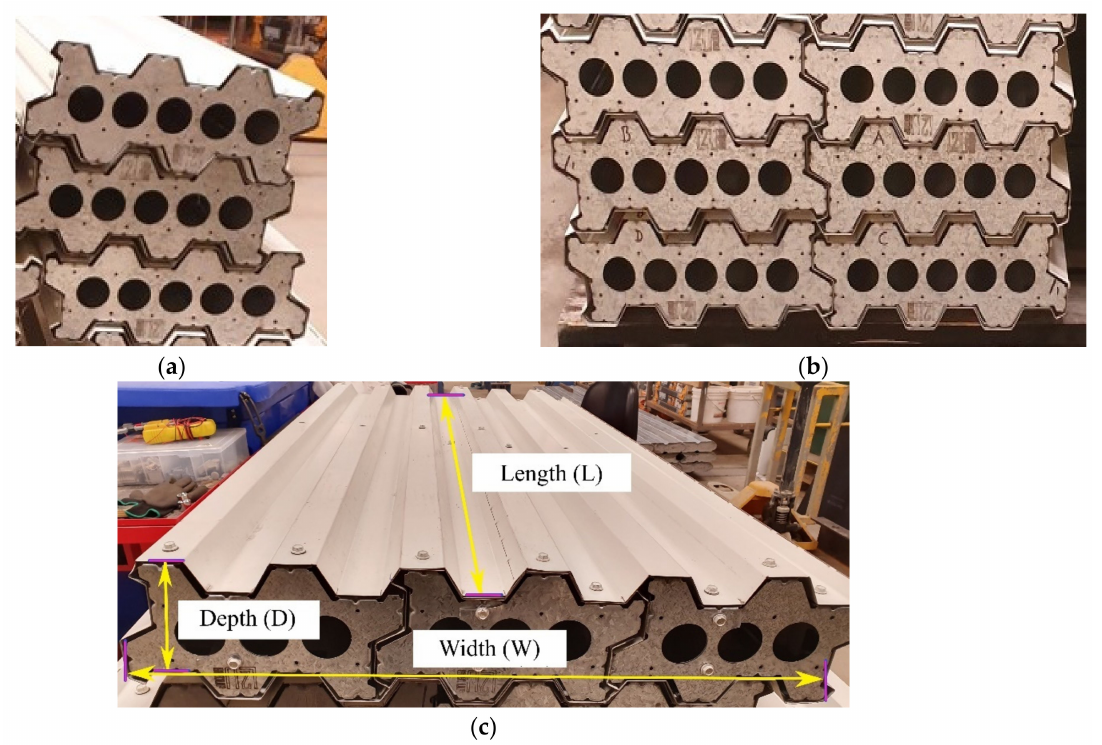
Figure 2. ( a ) Single-cell panels. ( b ) Double cell panels. ( c ) Triple Cell Panels with annotations of dimensions